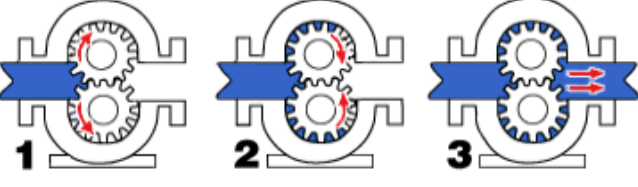
Figure 1. Fluid gear pump mechanism.